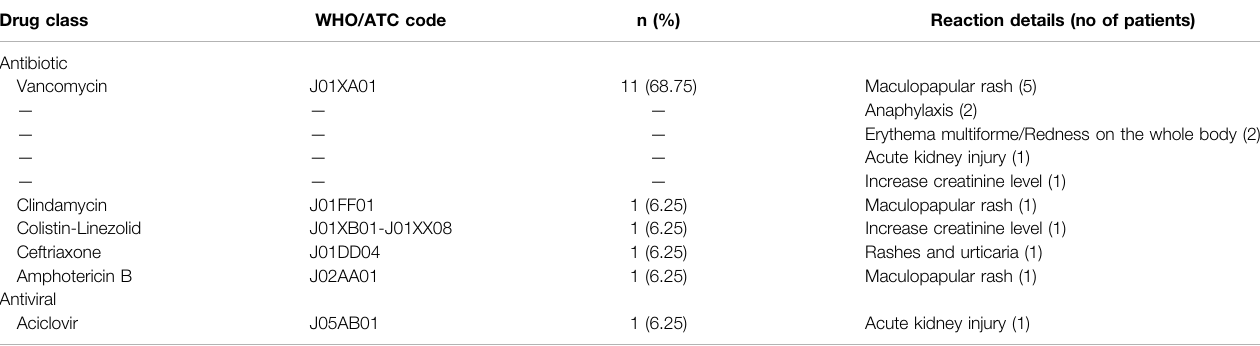
TABLE 2 | Drugs associated with